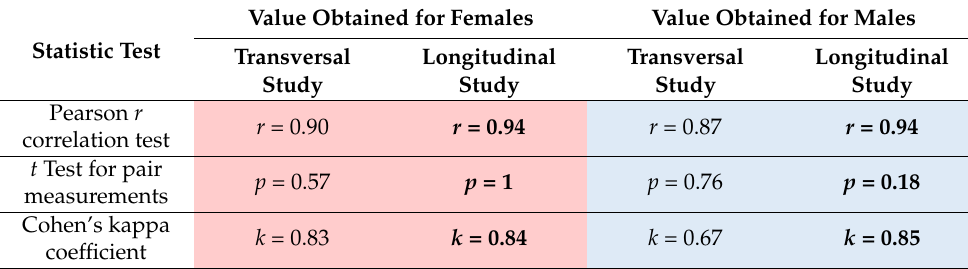
Table 4. Comparative analysis of the statistical data in the two studies. Value Obtained for Females Value Obtained for Males Statistic Test Transversal Longitudinal Transversal Longitudinal Study Study Study Study Pearson r correlation